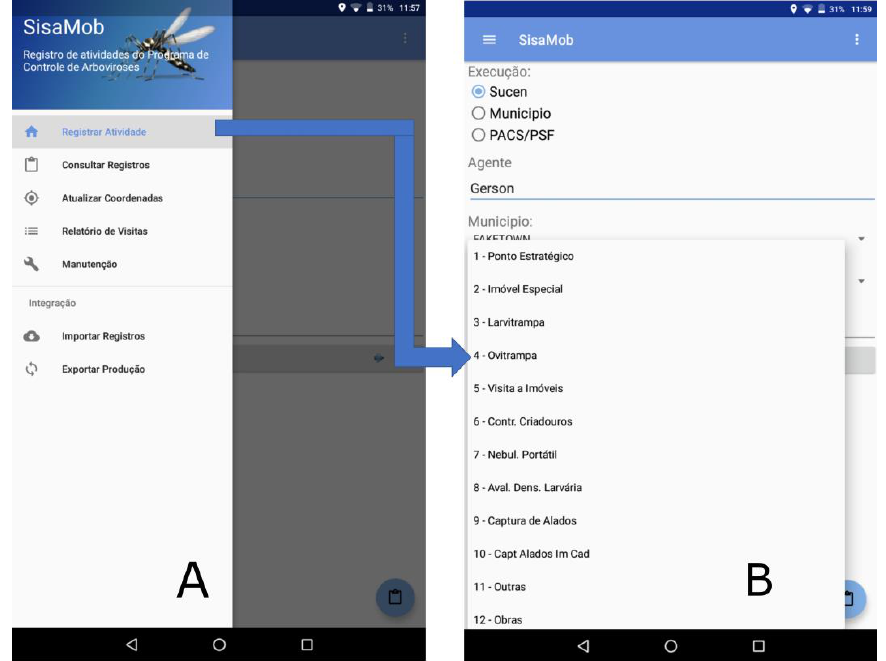
Figure 4 . ( A ) Activity selection; ( B ) List of available activities. Evaluation of the implementation of